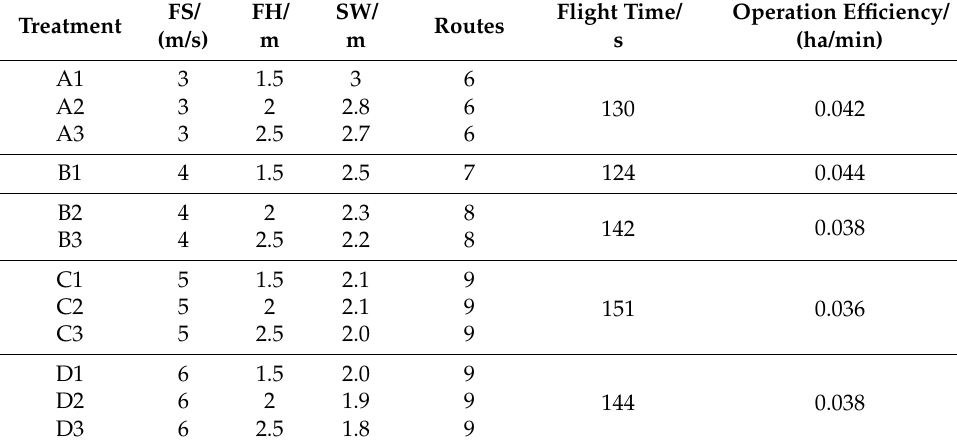
Table 8. Actual operation